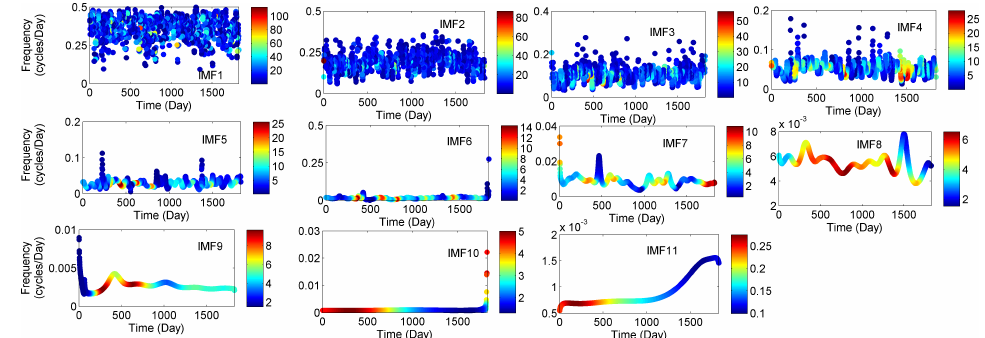
Figure 10. The time-frequency-amplitude spectra of the IMFs of wind direction.